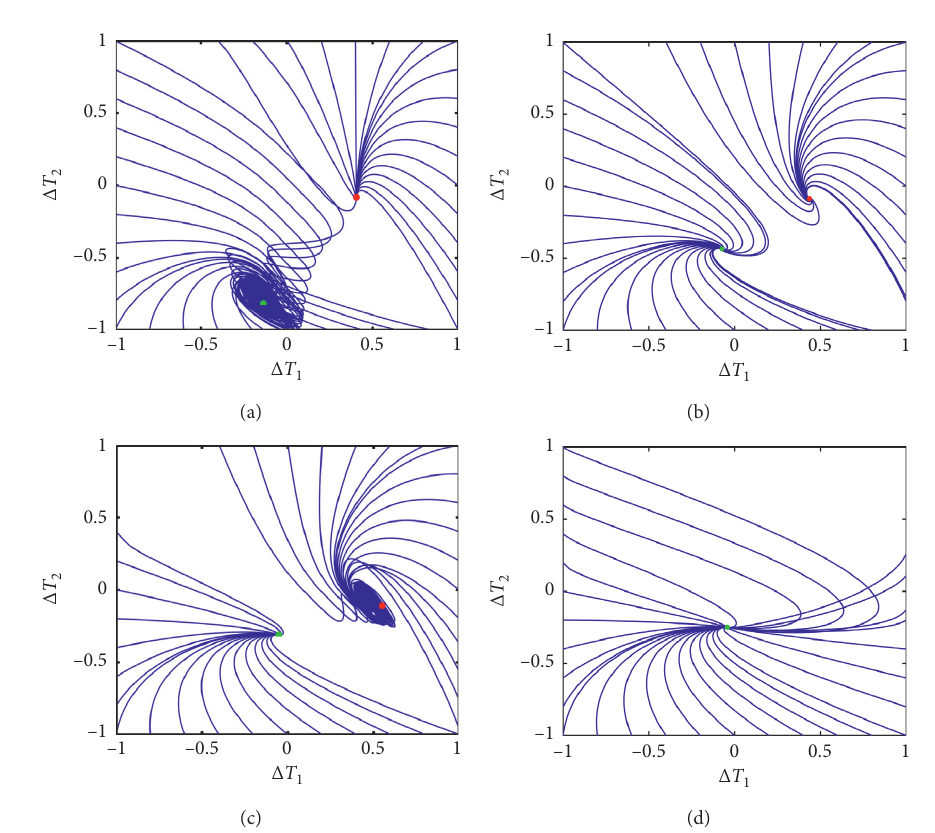
Figure 8: Phase portraits for different height ratios as k � − 1.2. (a) α � 0.01. (b) α � 1. (c) α � 3. (d) α � 6.